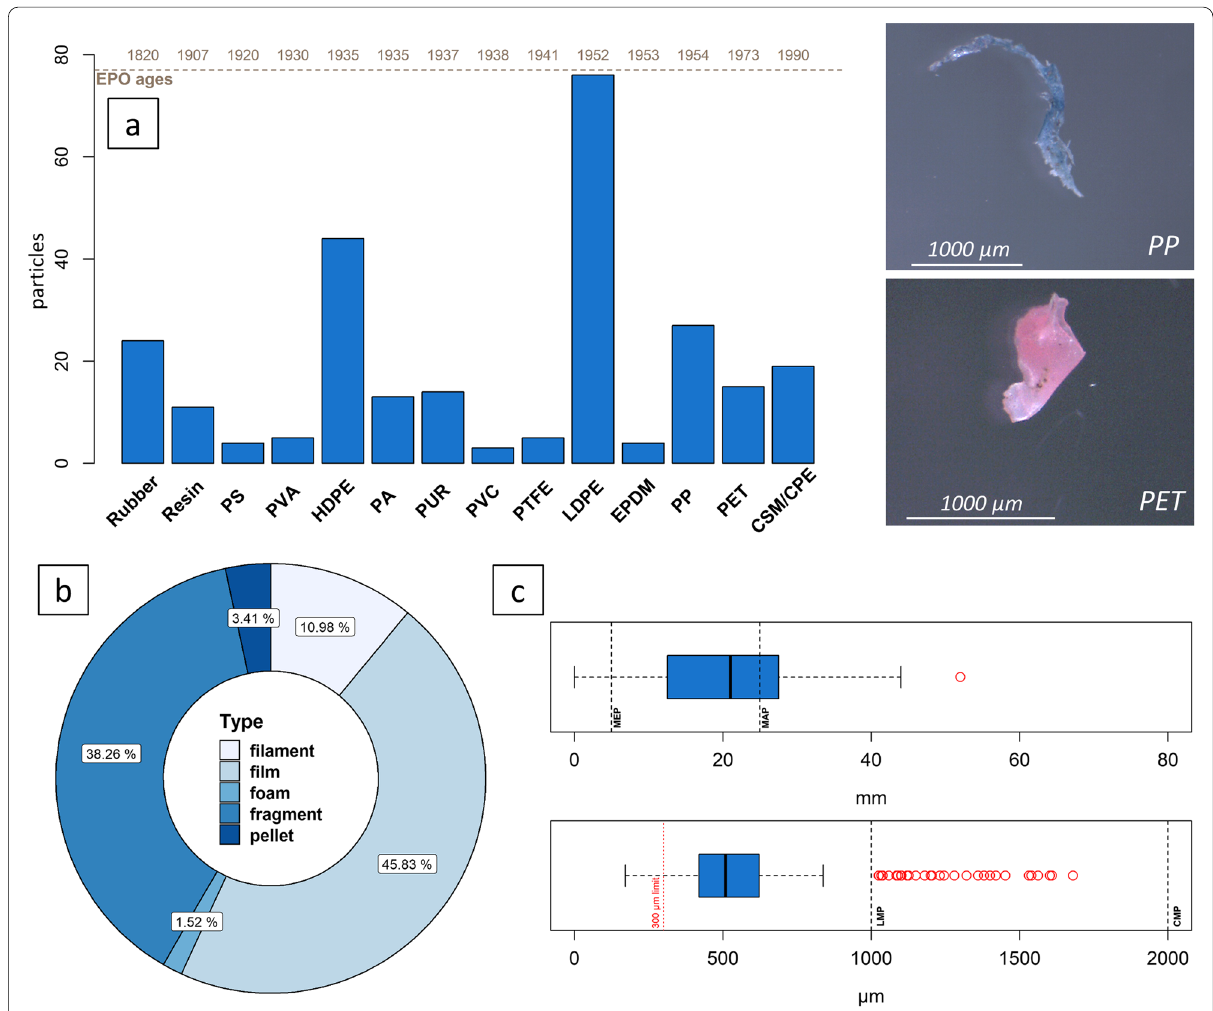
Fig. 2 Particle feature composition. a Number of identified polymer types ( n example of a blue PP film and pink PET fragment (Polymer type abbreviations explained in Table S4); b Particle type composition ( n size composition for particles in coarse soil fraction (> 2 mm) (upper boxplot, n and third quartile represented by outer box